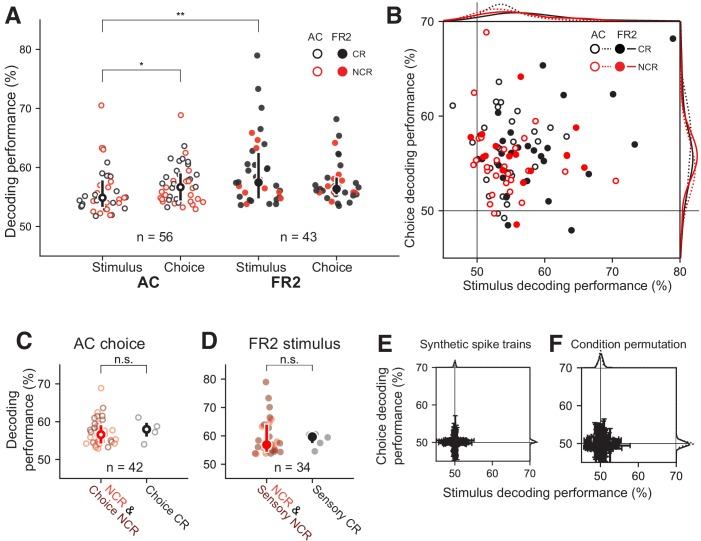
Decoding performance of single-units recorded from AC or FR2.(A) Decoding performance of single-units for stimulus category and behavioral choice in AC (open circles) and FR2 (filled circles) restricted to those statistically significant relative to synthetically-generated spike trains (p<0.05, permutation test, two-sided). Note that decoding performance values reflect the algorithm’s prediction certainty on individual trials. Central symbol with error bars represents group medians and top and bottom quartiles (*p=0.02, **p=0.001, Mann-Whitney U test, two-sided). Black symbols, classically responsive cells; red symbols, non-classically responsive cells. (B) Weighted decoding performance for choice versus stimulus, restricted to those statistically significant relative to synthetically generated spike trains for either stimulus, choice, or both (p<0.05, permutation test, two-sided). Black symbols, classically responsive cells; red symbols, non-classically responsive cells. This performance metric is weighted by the prediction certainty on individual trials and can be thought of as a confidence measure. (C) Choice decoding performance in AC of non-classically responsive cells (red) and choice non-classically responsive (dark-red) versus choice classically responsive cells (black; i.e. ramping cells). Decoding performance was not statistically different (p=0.32 Mann-Whitney U test, two-sided). Central symbol with error bars represents group medians and top and bottom quartiles. (D) Stimulus decoding performance in FR2 for non-classically responsive cells (red) and sensory non-classically responsive (dark-red) versus choice responsive cells (black; i.e. ramping cells). Decoding performance was not statistically different (p=0.29, Mann-Whitney U test, two-sided). Central symbol with error bars represents group medians and top and bottom quartiles. (E) Decoding performance for choice versus stimulus, applied to spike trains synthetically generated from sampling (with replacement) over all ISIs observed without regard to stimulus category or behavioral choice. Black, classically responsive cells; red, non-classically responsive cells. Error bars represent standard deviation. (F) Decoding performance for choice versus stimulus, applied to spike trains left intact but trial conditions (stimulus category and behavioral choice) were randomly permuted (1000 permutations per unit). Error bars represent standard deviation.